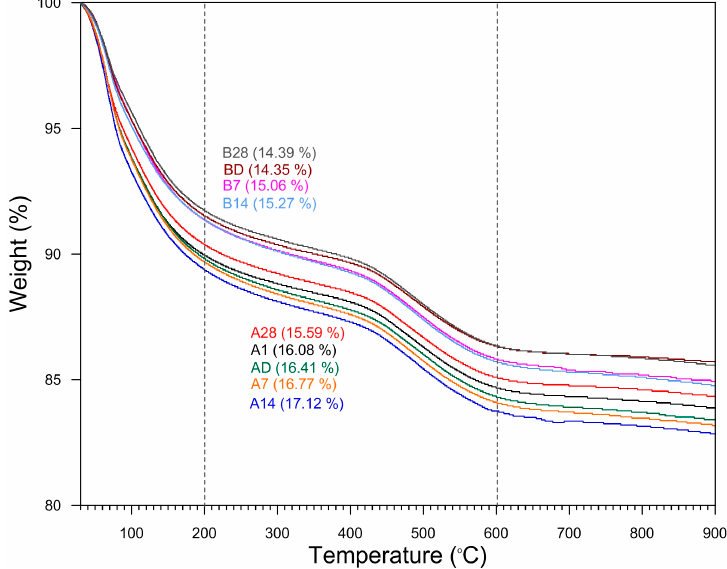
Figure 3. Thermogravimetric curves for the sealed “A” and the unsealed “B” series geopolymer specimens. The sealed “A” series specimens lost relatively more moisture at low temperatures and the weight loss at high temperatures was reversed.